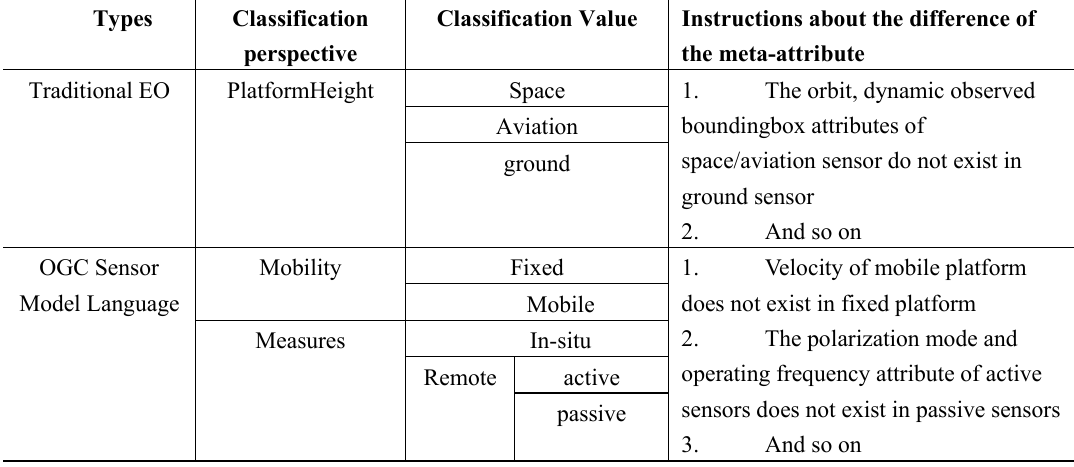
Table 4. Earth Observation (EO) sensor classification and analysis of different meta- attribute